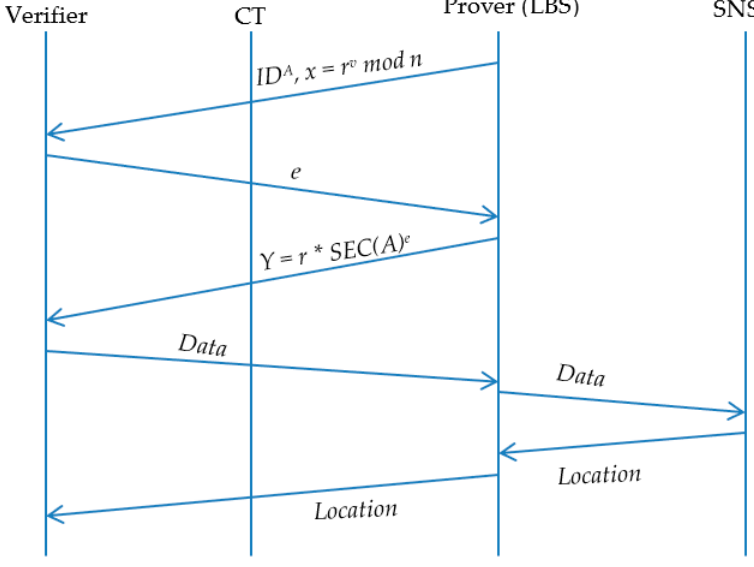
Figure 8. BL0K sequences of querying users’ locations.